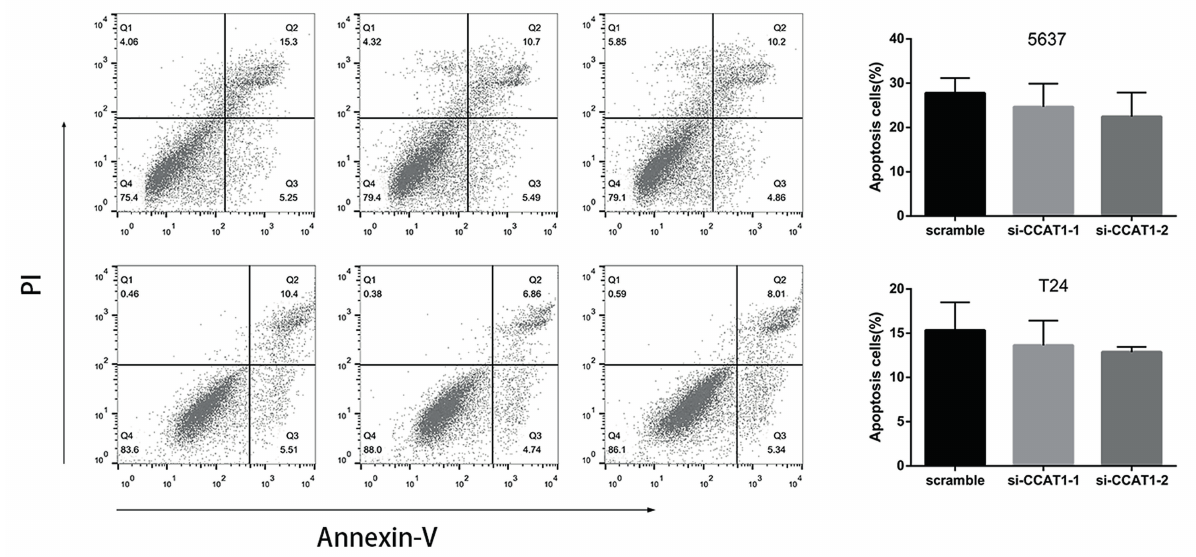
Supplemental Figure 2 - Representative flow cytometric plots of cell apoptosis. Cells were stained with both Annexin V and PI before analysis by flow cytometry. Numbers represent the percentage of the frequency in each quadrant.